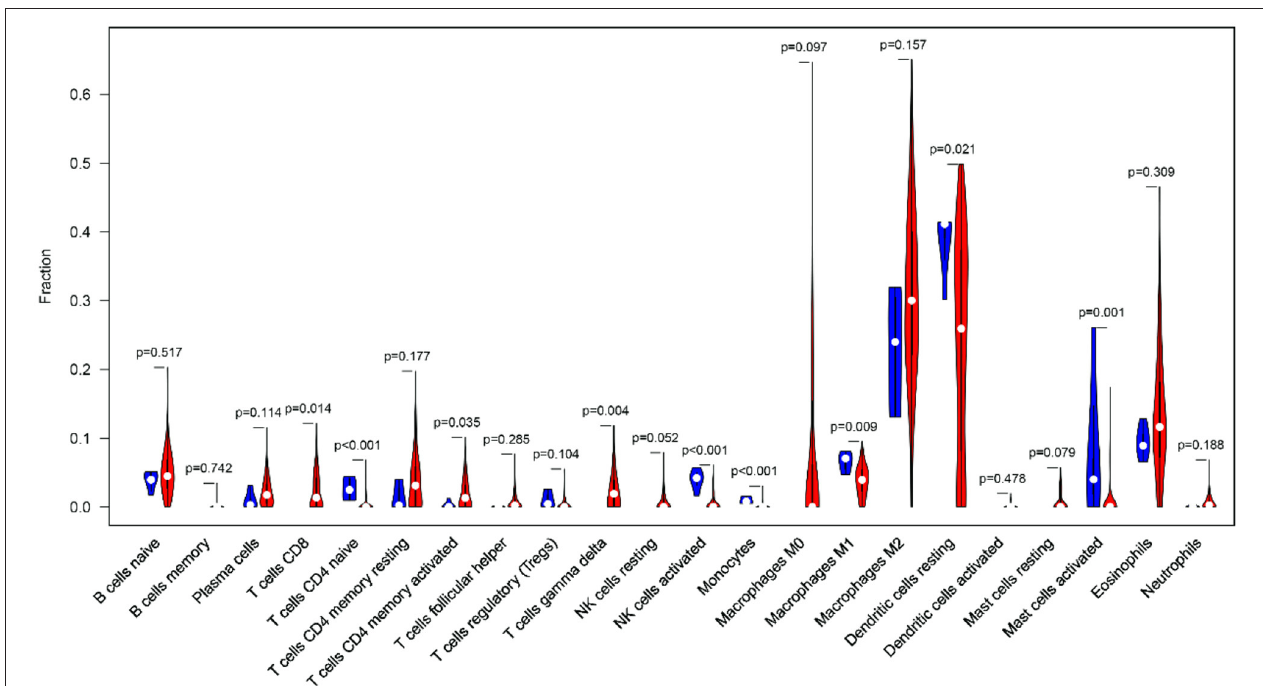
FIGURE 10 | The violin plot shows the infiltration levels of 22 types of immune cells (blue and red represent normal and GBM samples,